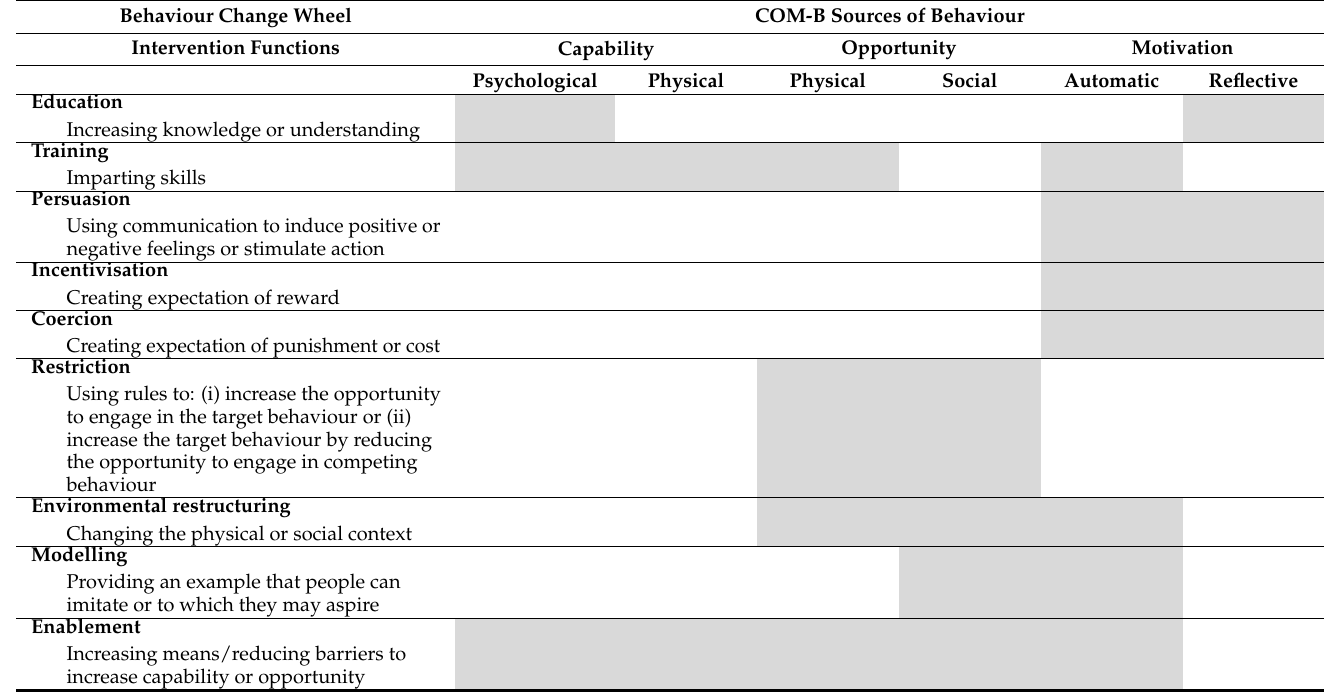
Table 1. Mapping 1 of Behaviour Change Wheel intervention strategies to COM-B sources of be- haviour